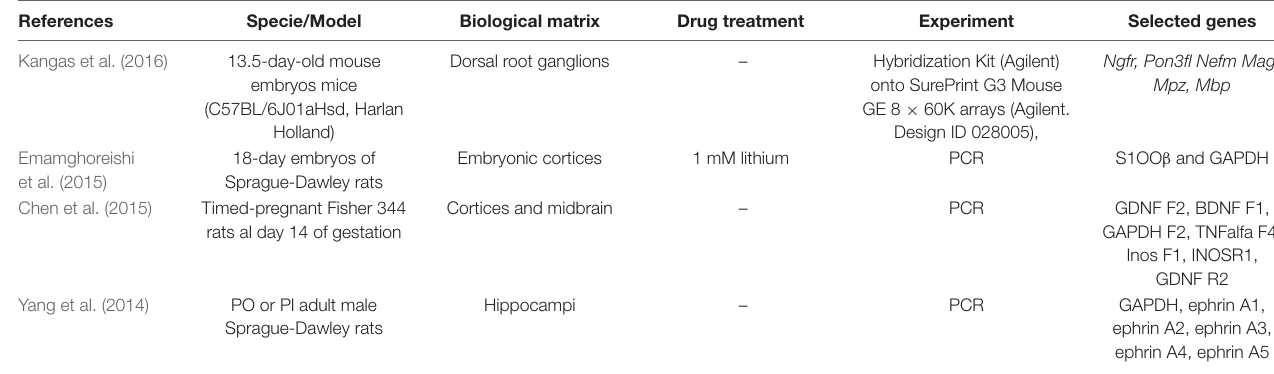
TABLE 2 | Characteristics of the eligible studies selected from literature